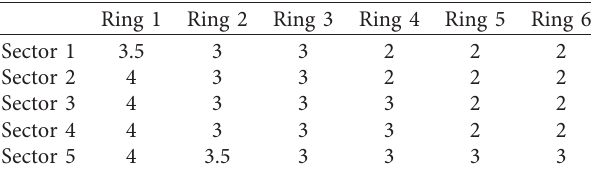
Figure 3: Division of the typical cross section. Table 2: Corrosion stages in the critical cross section.